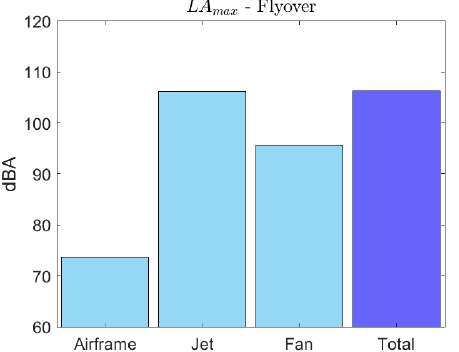
Figure 10. Noise contributions and overall noise for sideline measurement point.